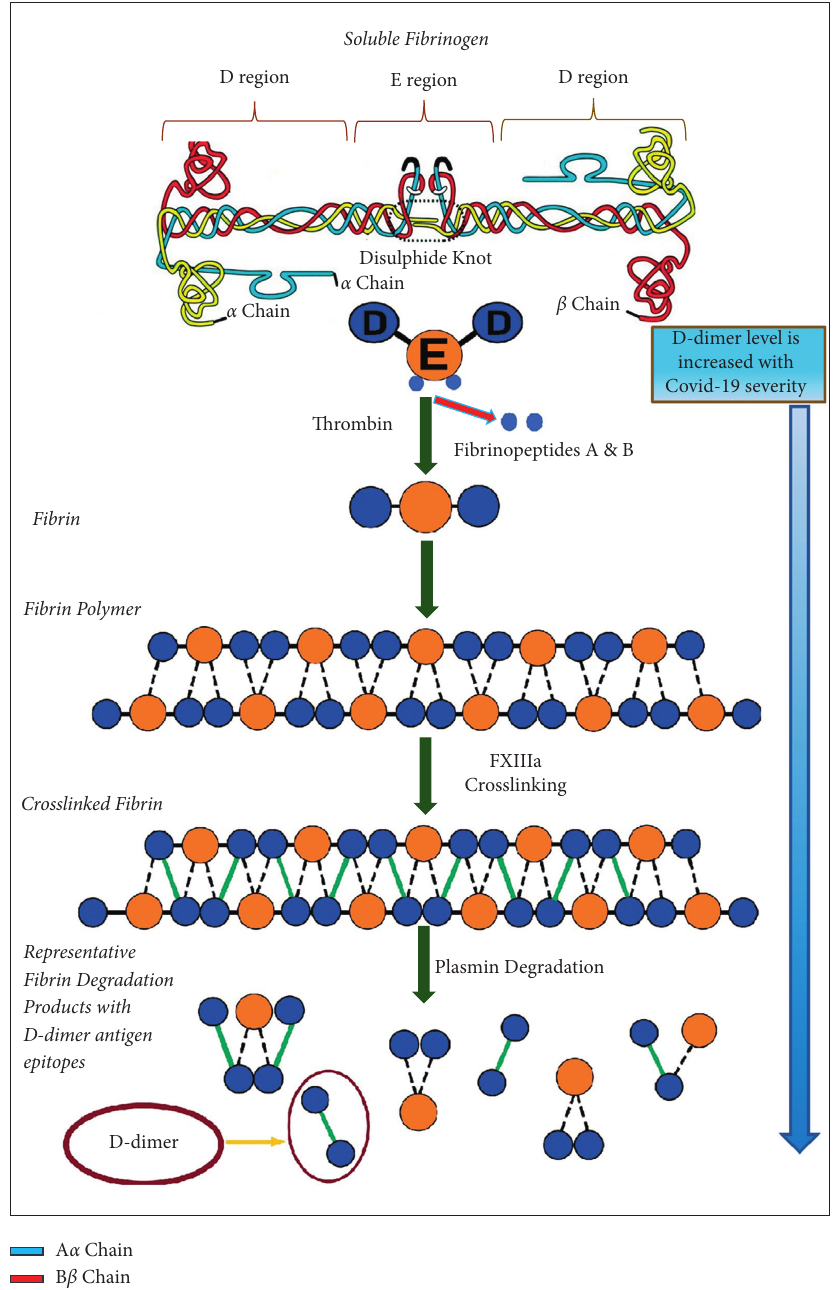
Figure 1: Schematic illustration of Fibrin structures of human (A) fibrinogen and (B) fibrin fibers. The fibrin structure was constructed by performing a best fit of each end of fibrinogen to each D region of the D dimer. Fibrinogen is clotted by thrombin, and the fibrin monomers that are produced polymerize spontaneously in a half-staggered format into protofibrils. The fibrin network is enhanced by factor XIIIa, which crosslinks adjacent monomers. Plasminogen activation is enhanced with fibrin formation, and the resultant plasmin digests the individual fibers. Plasmin cleavage between the D and E domains yields (DD)E, and the noncovalent complex of D-dimer (DD) and fragment E. D-dimer level is increased with COVID-19